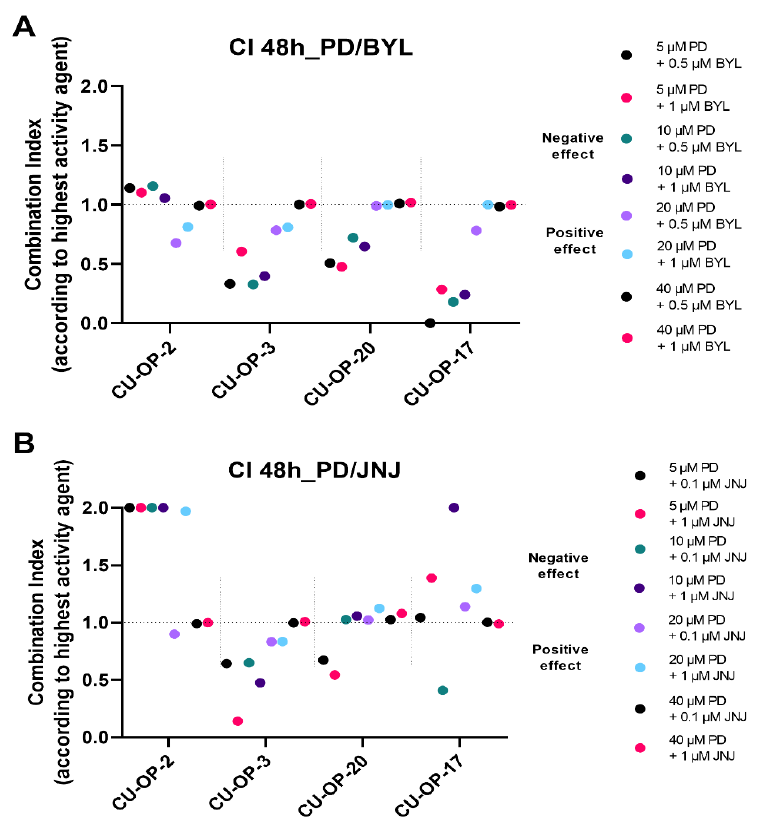
Figure 4. Combinational effects of CDK4/6 inhibitor PD-0332991 and PI3K inhibitor BYL719 ( A ) and PD-0332991 and FGFR inhibitor JNJ-42756493 ( B ) after 48 h. Combination indexes (CIs) were shown with the highest single agent approach after 48 h ( A , B ) and 72 h, where CI > 1 shows a negative combination effect and CI < 1 shows a positive combination effect. CIs were calculated from the mean of three experiments analyzed by WST-1, at 48 h after treatment. CI denotes combinational index; PD denotes PD-0332991; BYL denotes BYL719; and JNJ denotes JNJ-42756493. PD-0332991 and BYL719. Combinations of all doses of the CDK4/6 inhibitor PD- 0332991 with the lowest concentr ation of BYL719 0.5 μM resulted in synergistic, or mainly positive or neutral combinational effects (CI < 1) after 48 h, for CU-OP-3, CU-OP-20, and CU-OP-17, while this was not as much the case for CU-OP-2, that also showed a marginal negative effect (Figure 4A) . With the BYL719 1μM dose , all combinations with PD-0332991 mainly resulted in positive or neutral effects (CI < 1 or CI = 1) for all cell lines after 48 h. (Figure 4A). To summarize, combining the CDK4/6 inhibitor with the PI3K inhibitor, generally resulted in a positive or neutral combinational effect in most cell lines except occasionally for CU-OP-2. PD-0332991 and JNJ-42756493. Combinations with the different doses of the CDK4/6 inhibitor PD-0332991 and the two doses of the FGFR inhibitor JNJ-42756493 are shown in (Figure 4B). Mainly positive or neutral combinational effects (CI < 1) were found when combining PD-0332991 and JNJ-42756493 after 48 h especially for CU-OP-3 and CU-OP- 20, while both CU-OP-2 and CU-OP-17 showed negative or neutral effects after 48 h.